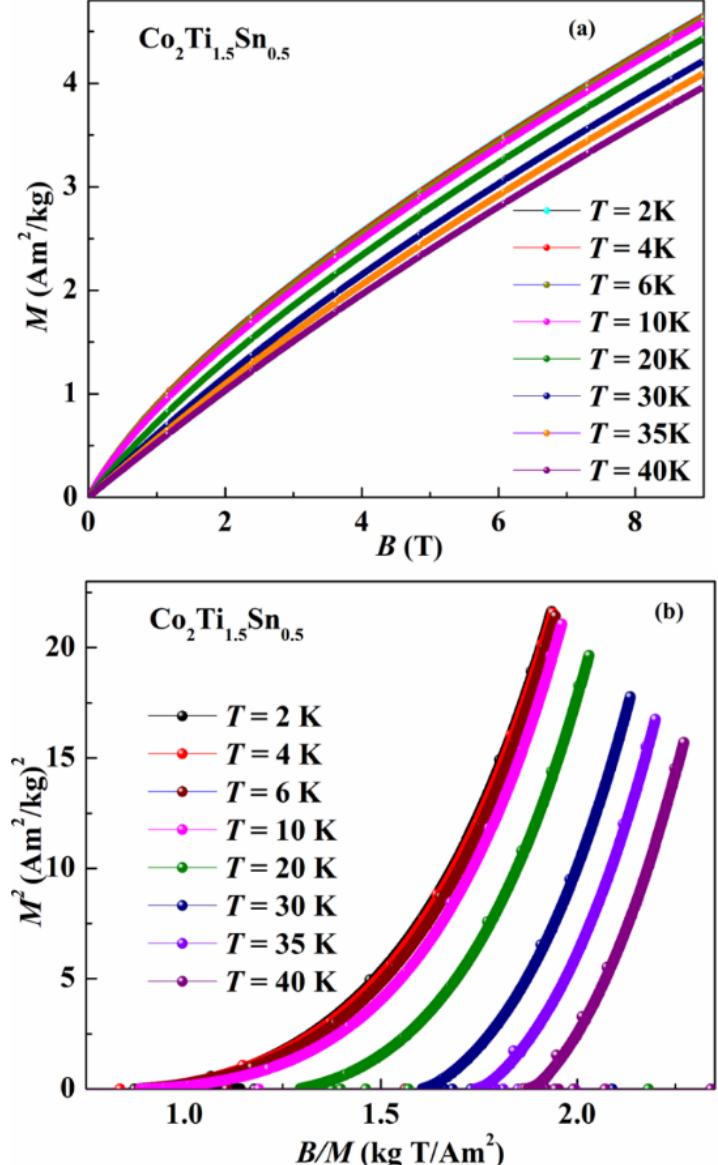
Figure 3. ( a ) Field-dependent isothermal magnetization M(B) of Co 2 Ti 1.5 Sn 0.5 alloy at various tem- peratures. ( b ) Arrott plot of Co 2 Ti 1.5 Sn 0.5 alloy.